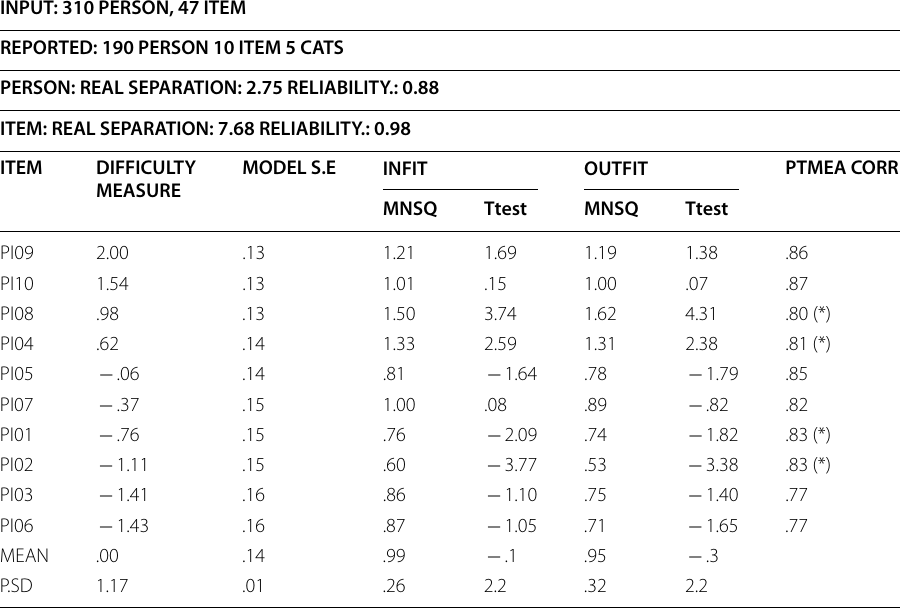
Table 5 Dimension PI: Item difficulties, standard errors, Infit, Outfit, T-test and correlations, estimated from final models (*)